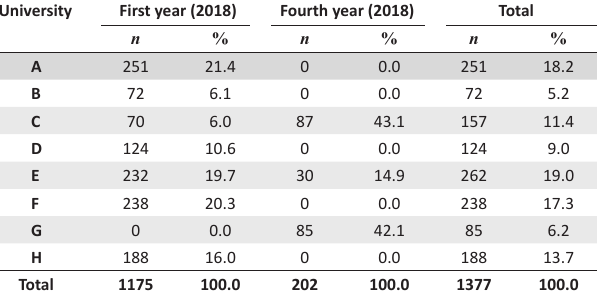
TABLE 1: Student sample participating in the 2018 PrimTEd